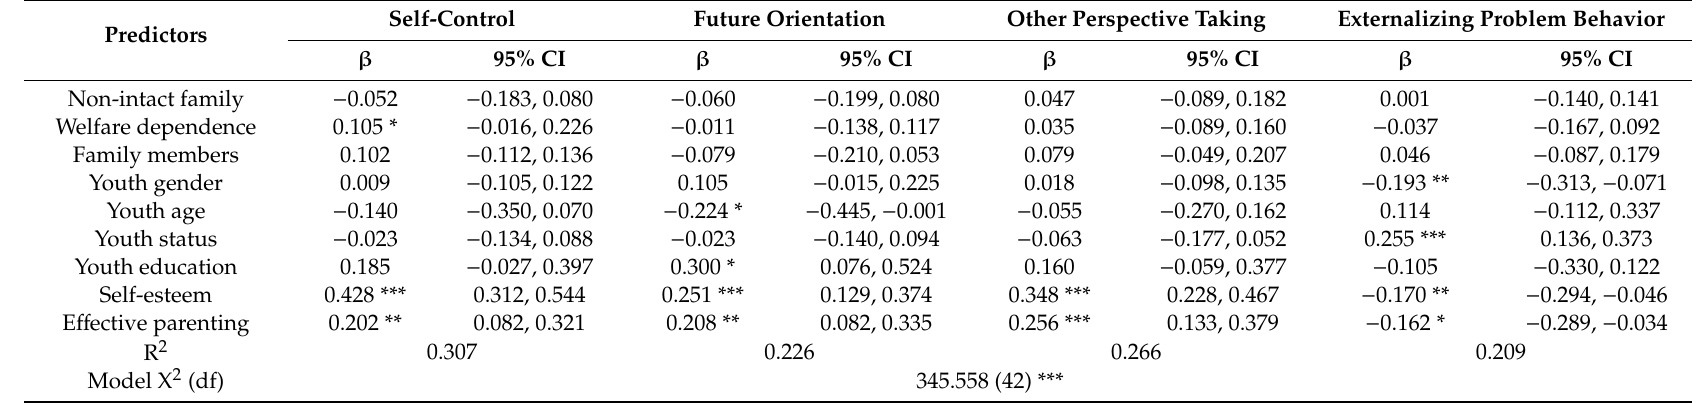
Table 4. Multivariate linear regression modeling predicting self-control, future orientation, other perspective taking and externalizing problem behaviors of youth by their self-esteem and authoritative